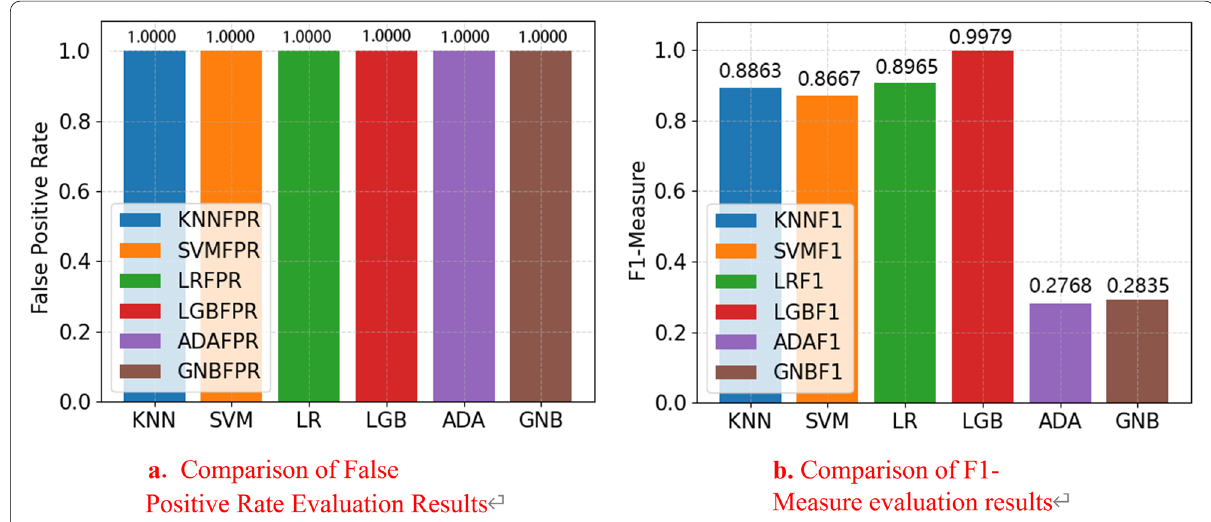
Fig. 5 Comparison of False Positive Rate Evaluation